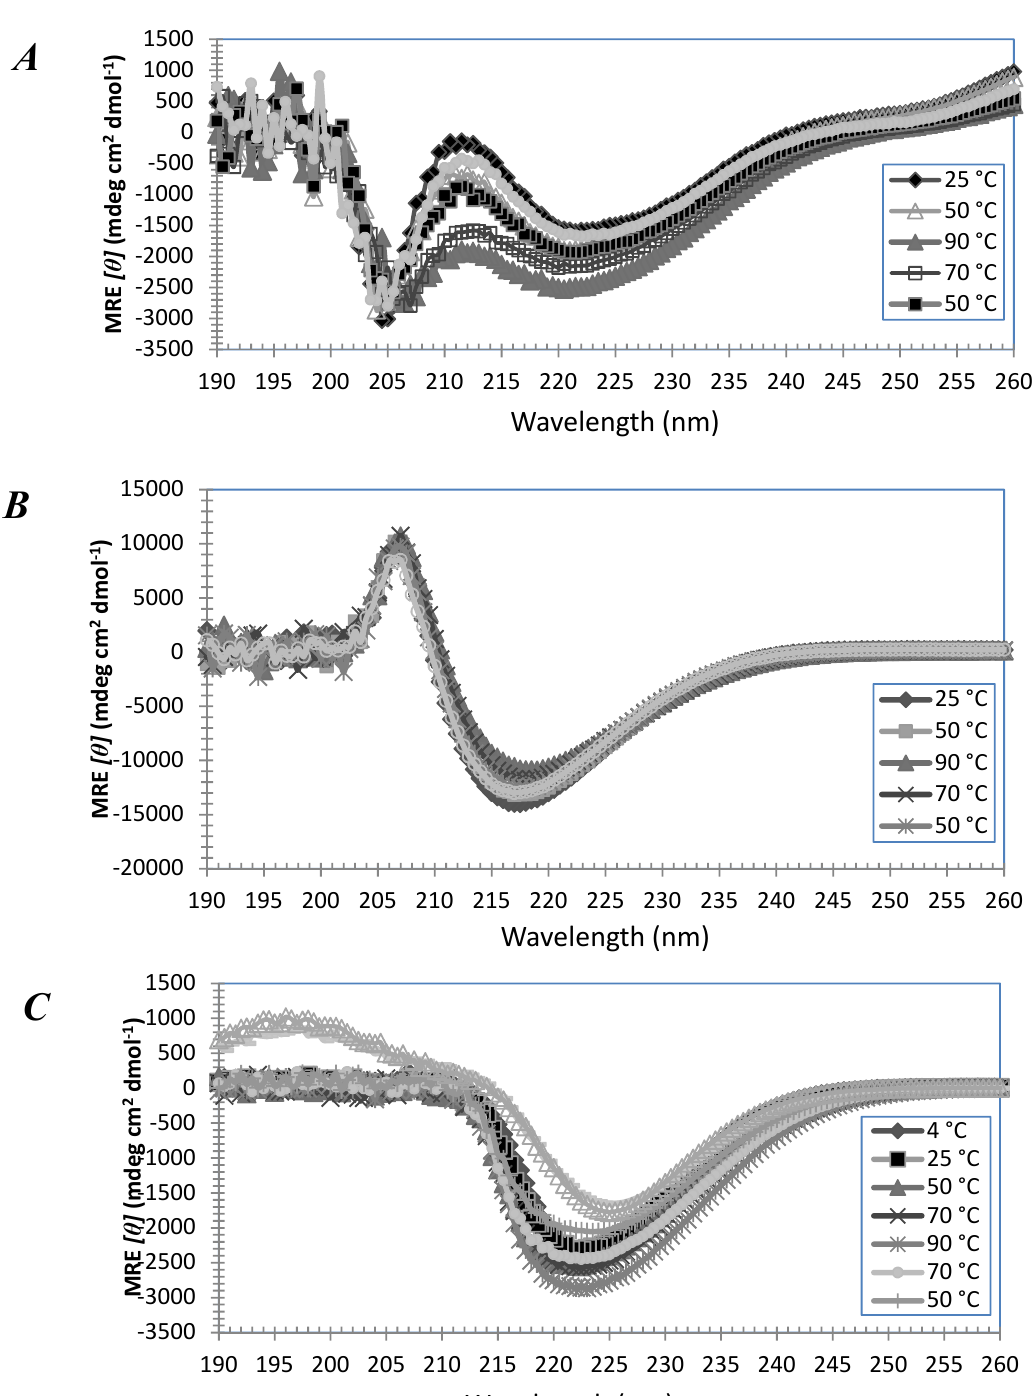
Figure 3. ( A ) Mean residue ellipticity (MRE) of 2.5 mM A negative MRE at 208 nm and 222 nm indicates a predominantly α -helical structure. ( B ) MRE of 2.5 mM A D, and ( C ) MRE of 10 mM A 6 around 217 nm indicates β -sheet structures. ( D , E ) FESEM images of 2.5 mM A ( F , G ) 2.5 mM A D, without 6